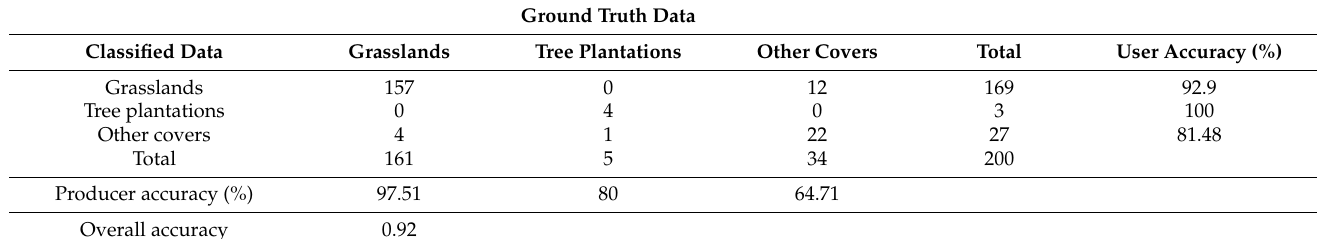
Table A15. Error matrix for the unsupervised classification for the period 1999–2000 based on 200 random points distributed across the Aguapey VGA. The diagonal contains correctly classified